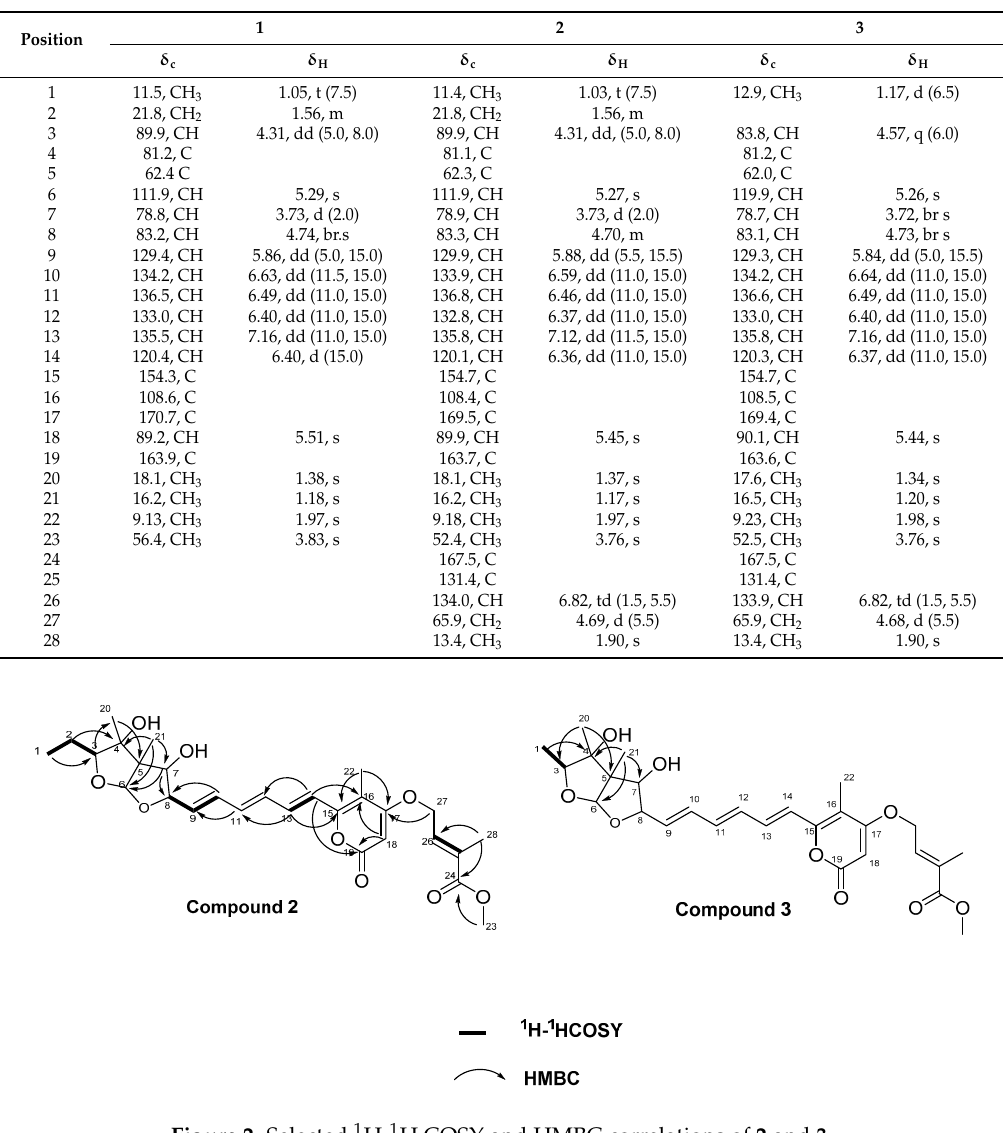
Table 1. The 1 H- and 13 C-NMR Data for 1 , 2 and 3 (500/125 MHz, respectively in CDCl 3 , δ ppm, J in Hz).